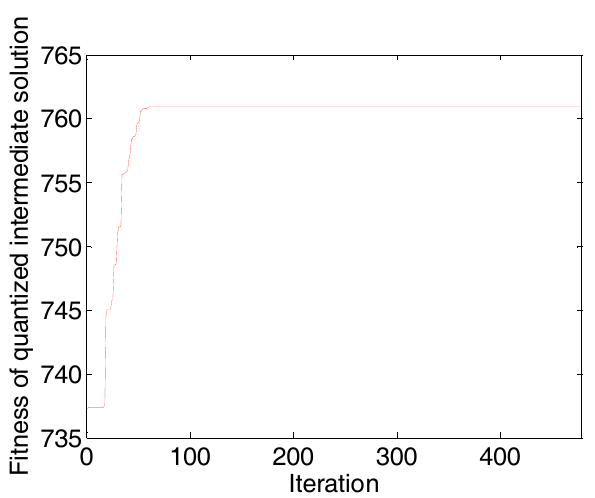
Figure 8. The convergence diagram of the AP algorithm (sweet orange leaves data) in the first round: Iterations vs. Fitness (net similarity) of quantized intermediate solutions. When the iteration is 486, the network is converged.